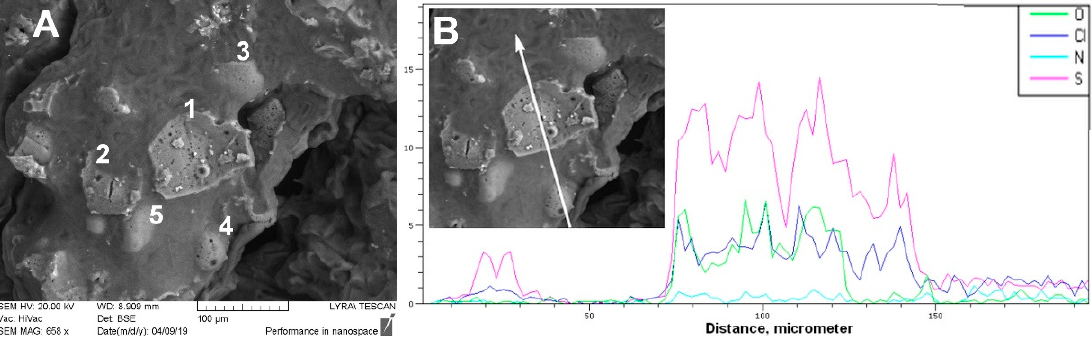
Figure 10. ( A ) SEM micrograph on microtome-made cuts of microsponge particles M-25 and ( B ) EDX analysis .